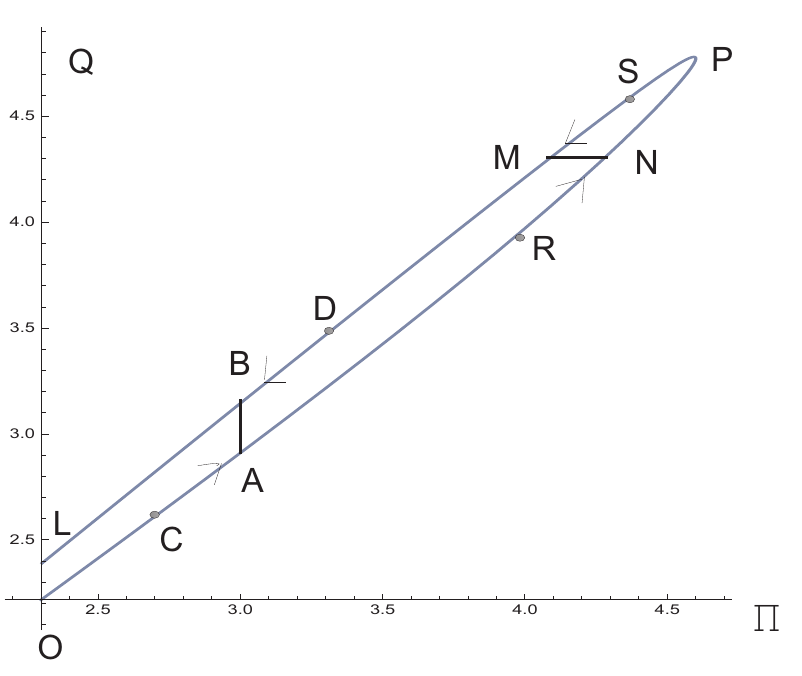
Figure 6. On the ( Π , Q ) -plane, the hysteresis loop corresponding to process (30) for rather small ε 20 , ε 30 , with Π 0 =